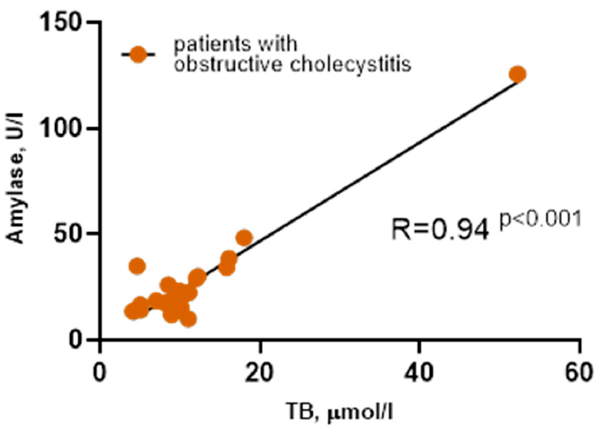
Figure 2. Correlation between plasma total bilirubin and amylase